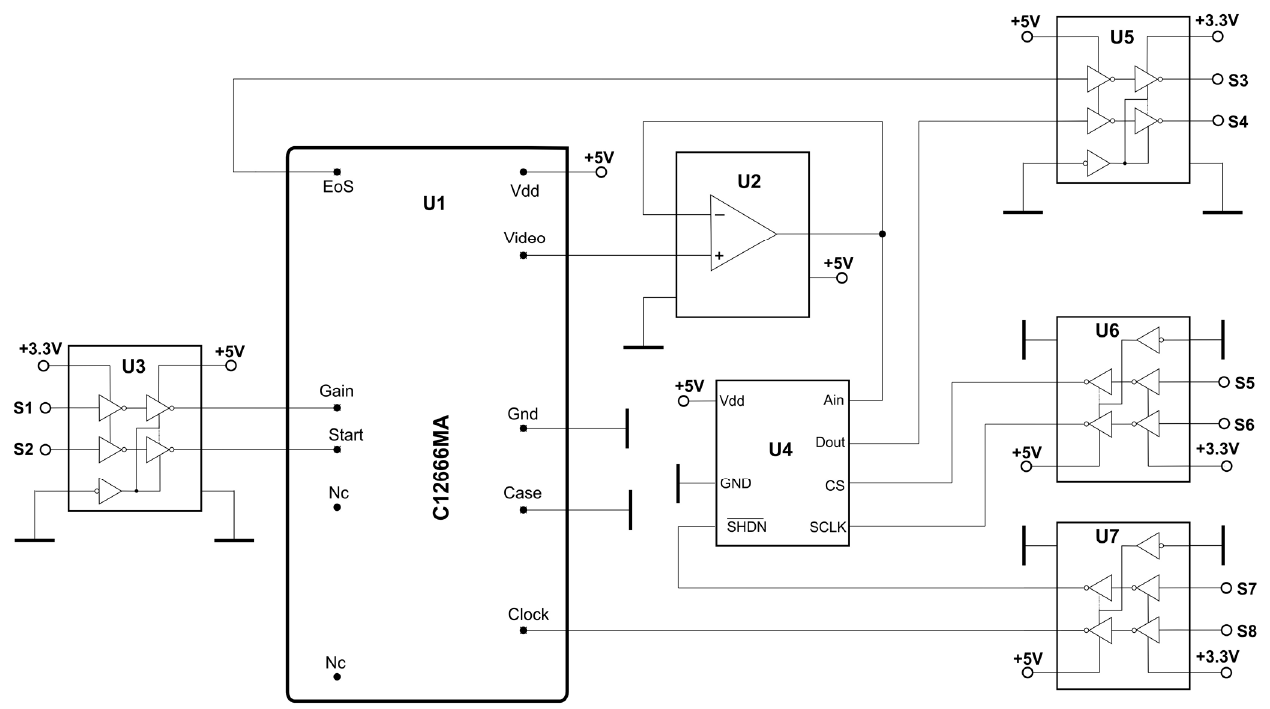
Figure 6. Default circuit of the C12666MA sensor.